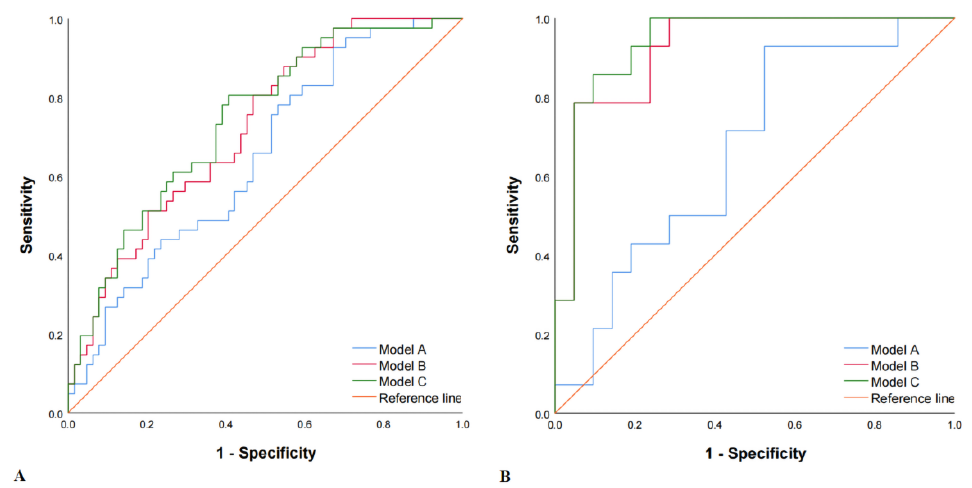
Figure 4. Receiver operating characteristic (ROC) curves in both the training and the validation set. Method A, Method B, and Method C represented the modeling methods of clinical features (HDL + Apo B), ultrasound features (plaque volume + Rad-score), and the combined model (HDL + Apo B + plaque volume + Rad-score). ( A ) Training set: the AUCs in Model A, Model B, and Model C were 0.648 (95% CI, 0.543–0.753), 0.723 (95% CI, 0.627–0.818) and 0.741 (95% CI, 0.646–0.835), respectively. ( B ) Validation set: the AUCs in Model A, Model B, and Model C were 0.667 (95% CI, 0.485–0.848), 0.922 (95% CI, 0.833–1.000) and 0.939 (95% CI, 0.860–1.000), respectively.